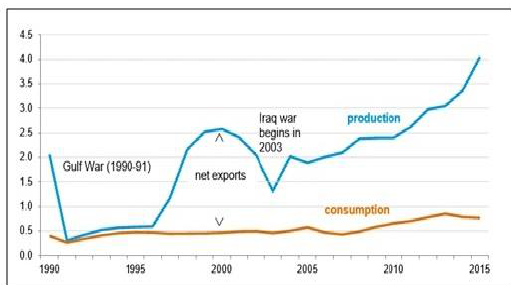
Figure 2. Iraq's Total Petroleum and Consumption Source: EIA, (2016).